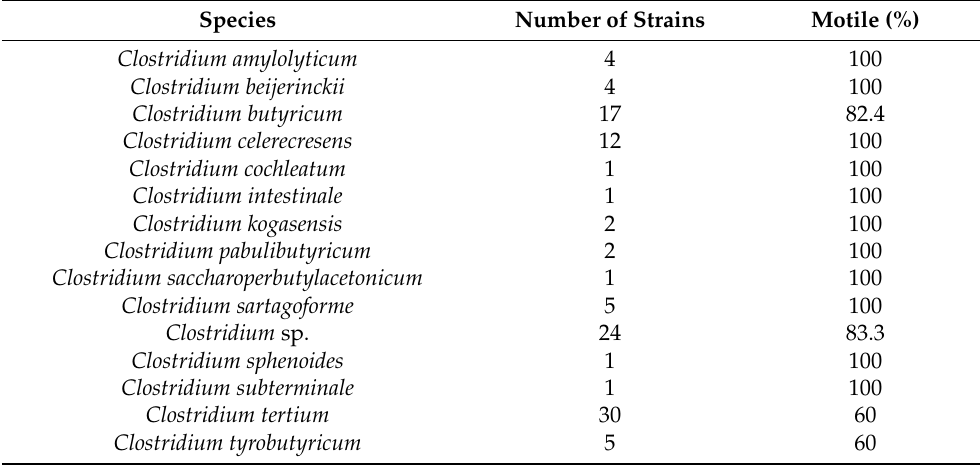
Table A2. Identification of Clostridium strains isolated from strong-flavor Baijiu pit